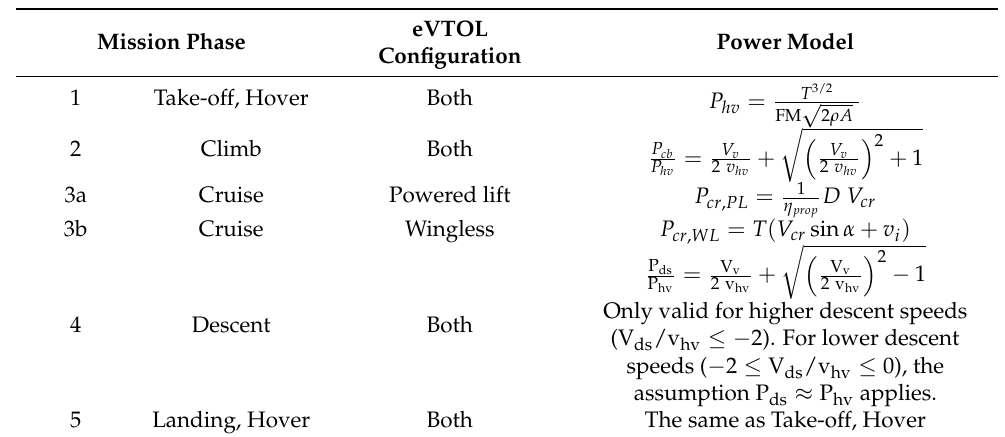
Table 1. Summary of configuration-dependent power models for all mission